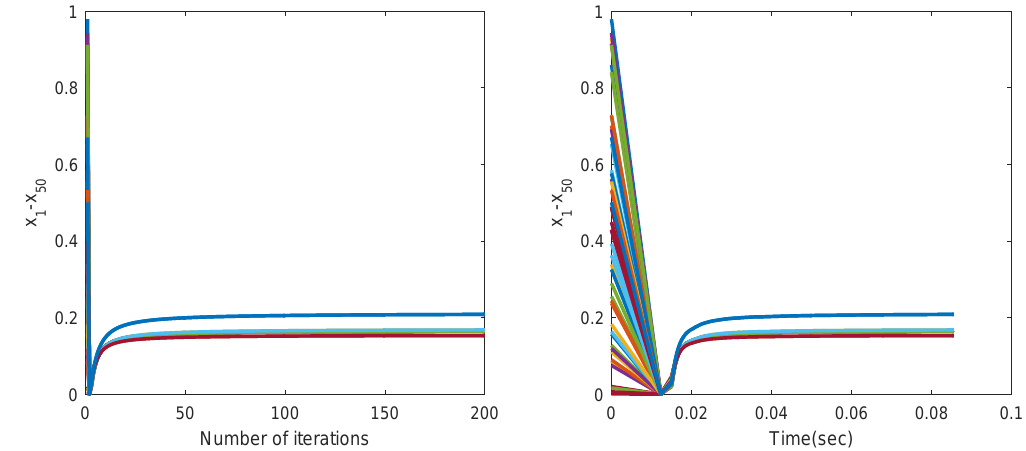
Figure 3. Behaviors of x 1 – x 50 with the number of iterations (resp.) k = 200. Numerical results for Algorithm 1.